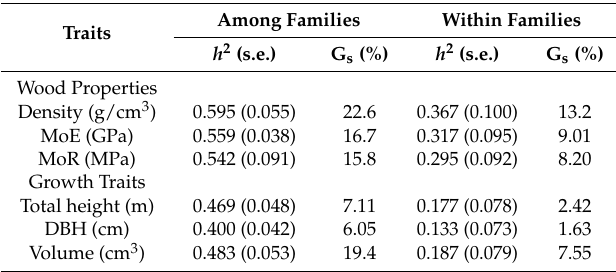
Table 1. Heritability ( h 2 ) and genetic gains (G S ) for wood properties and growth traits. Among Families Within Families Traits